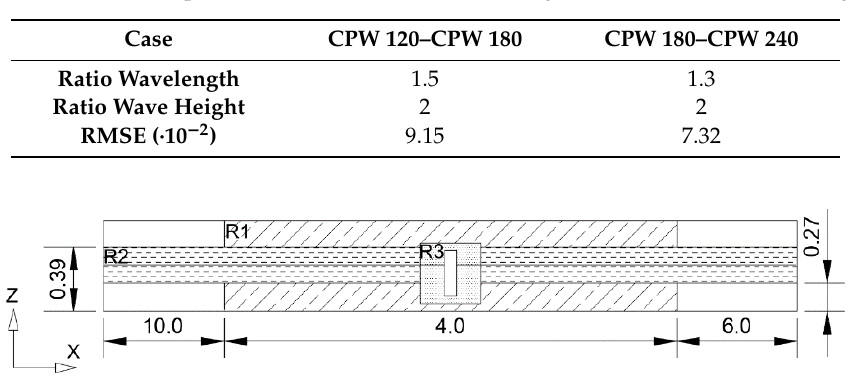
Figure 5. Mesh refined regions in the model (Units: Meters. Measures are not in scale. R1: Region close to the device, R2: Free surface region, and R3: Overset/front mesh).